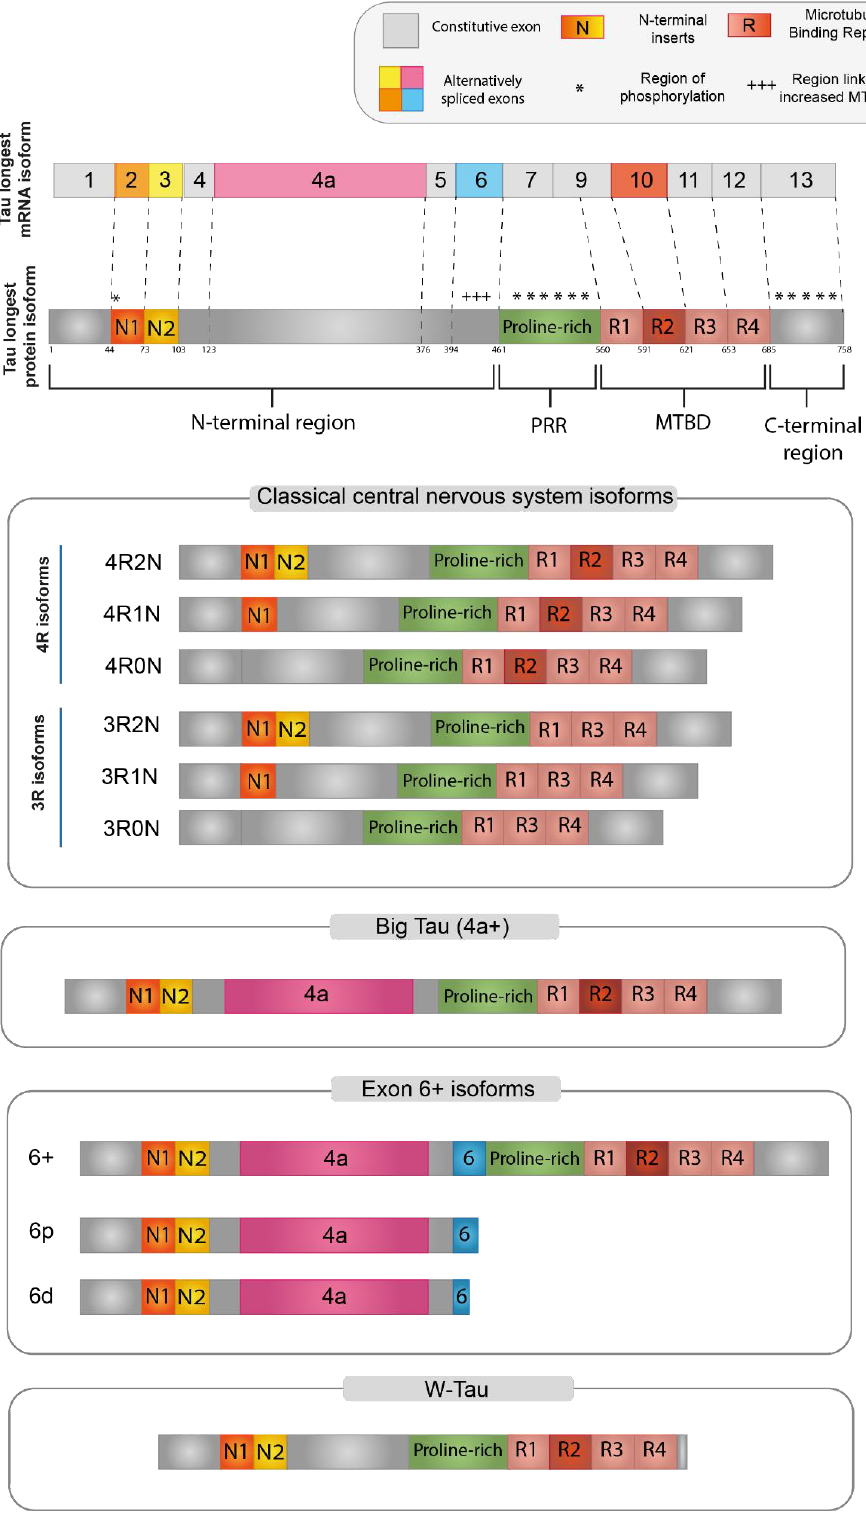
Figure 2. Tau protein isoforms. Schematic representation of the main Tau protein isoforms generated via alternative splicing. At the top, the longest Tau isoform found in humans, containing all the alternatively spliced exons. Red boxes represent the microtubule binding domain (MTBD), while the N-terminal projection domain is represented by exon 2 (orange) and exon 3 (yellow). For Big Tau (4+), Exon 6+ isoforms and W-Tau only the 2N4R isoforms are depicted, but all combinations are possible.